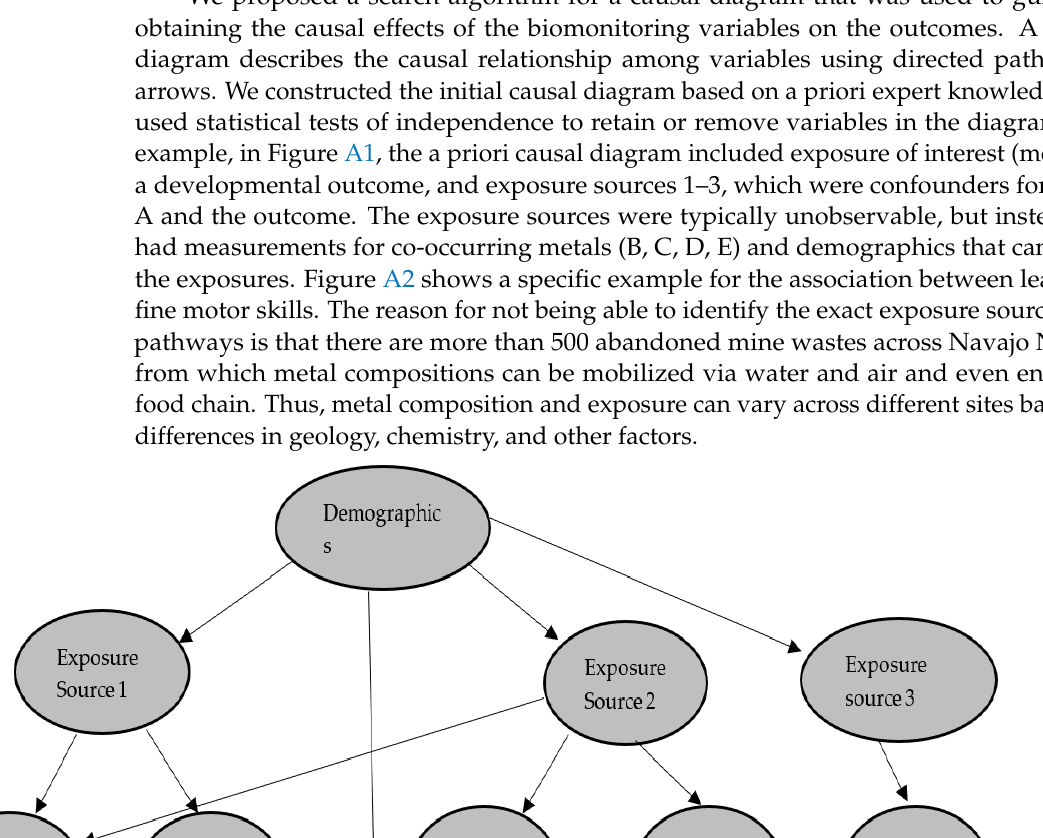
Figure A2. Causal directed acyclic graph for association between lead and fine motor skills.